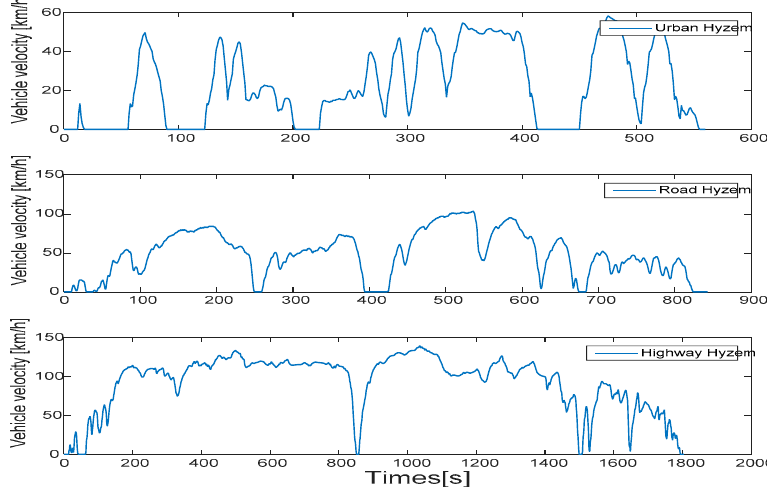
Figure 3. European Standard cycle WLTC (CLASSE3/BV).